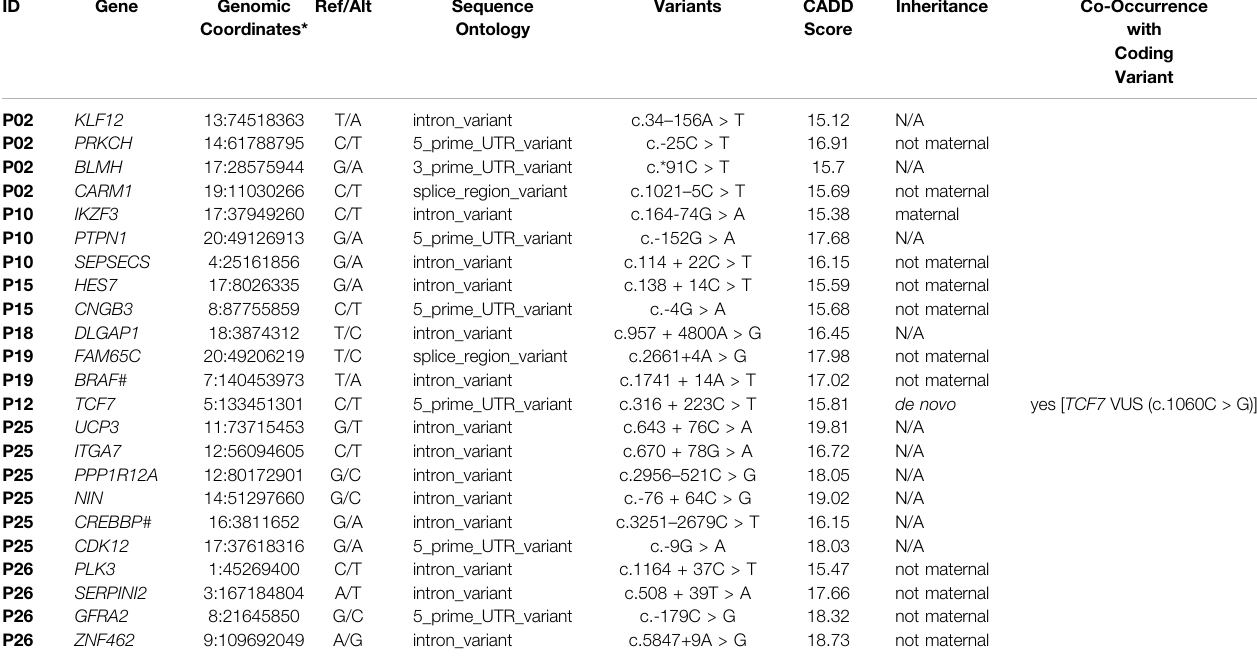
TABLE 4 | Rare germline non-coding variants detected in HB patients which were prioritized (CADD score above 15 and association with cancer).